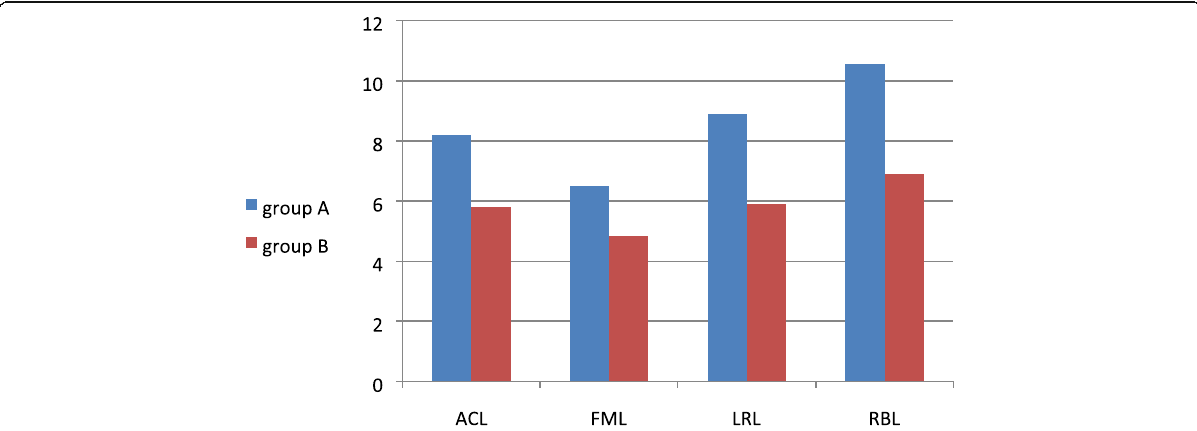
Fig. 2 Comparison of the mean scores of ACL, FML, LRL, and RBL after treatment between groups. ACL, attention and concentration training; FML, figural memory training; LRL, logical reasoning level; RBL, reaction behavior training